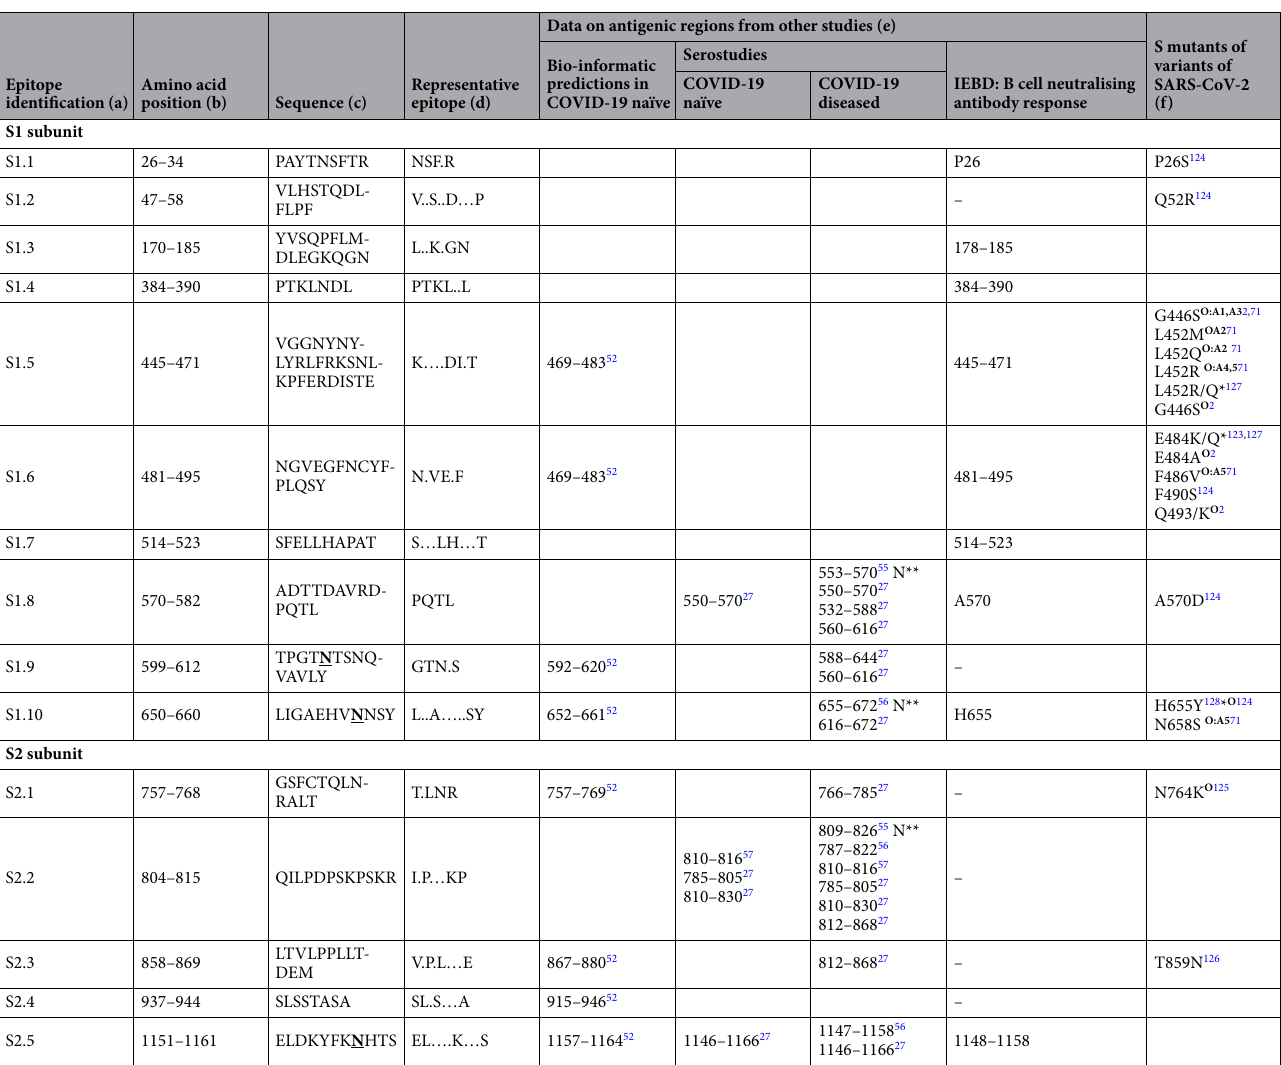
Table 2. The epitopes identified by MVA on SARS-CoV-2 spike glycoprotein are validated by using external data showing partial overlap with antigenic domains reported for COVID-19 naïve and diseased and with neutralising epitopes. The following information is given in columns: unique identification (a), amino acid position (b), amino acid sequence with glycosylation patterns bolded and underlined (c), representative Table S5) (e), frequent mutations described in new variants of being monitored (VBM) and of concern (VOC) of SARS-CoV-2 S 122 , where the highly mutated Omicron (B.1.1.529) sublineages (designated with “O”) that have enhanced transmissibility and mutations that show differential (often escape from) neutralising antibody response (marked with “*”) are shown in (f) as A1, A2, A3, A4, A5 —Omicron sublineages, BA1, BA2, BA3, BA4 and BA4 respectively. 2,71,99,109,122–126 . N neutralising/protective antibodies shown, ** , high IgG titre was associated with poor clinical outcome (development of pneumonia, needing care in the intensive unit or needing assisted pulmonary